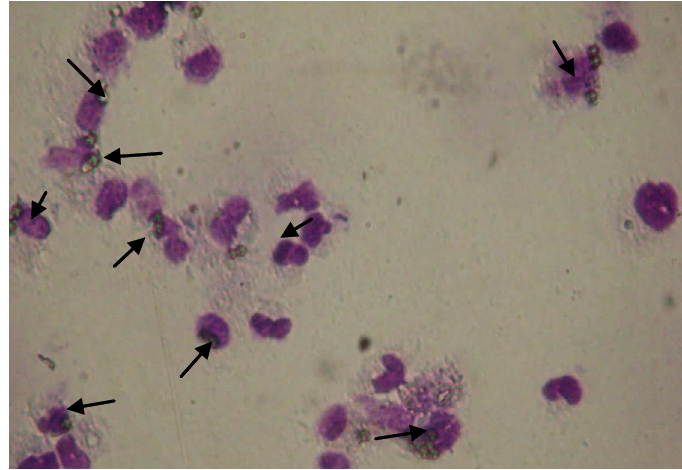
Gambar 1. Indeks fagositosis makrofag pada berbagai kelompok